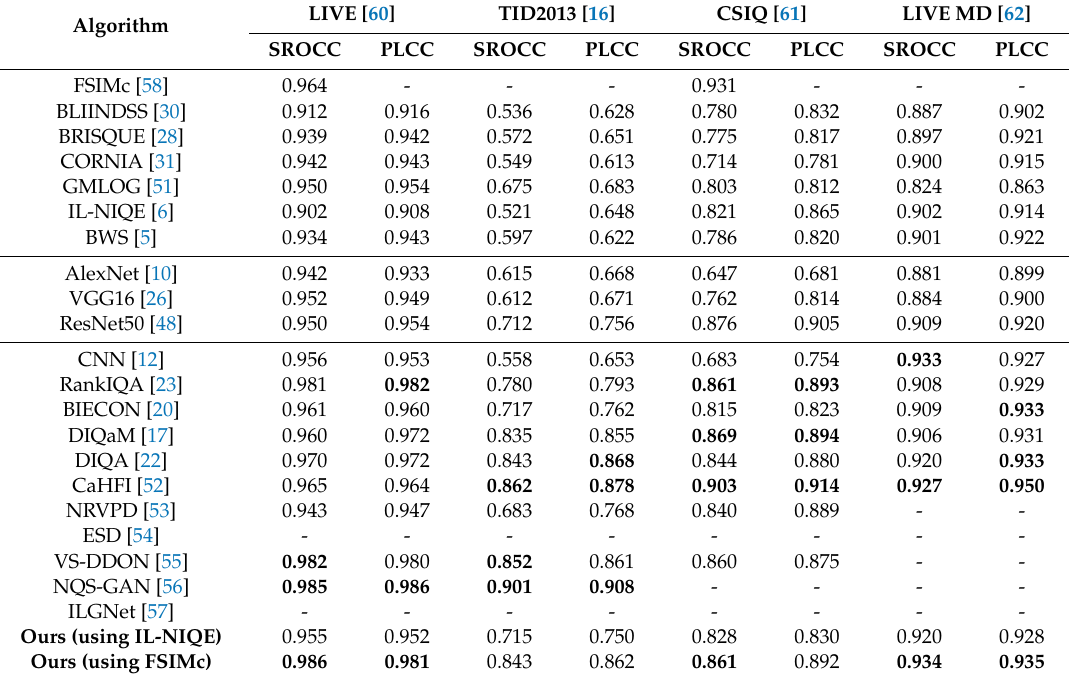
Table 8. Performance comparison between the supplement and other